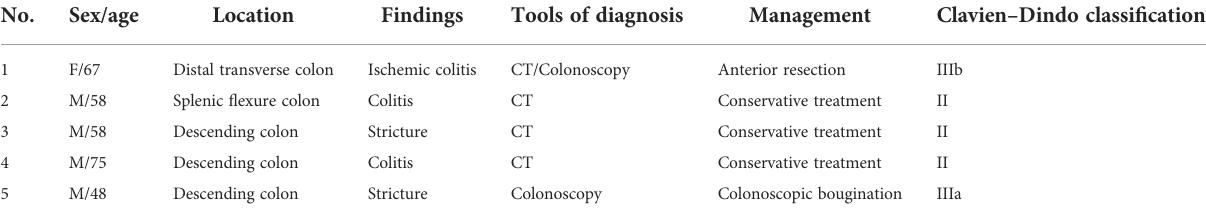
TABLE 4 Morbidities in the inferior mesenteric vein ligation